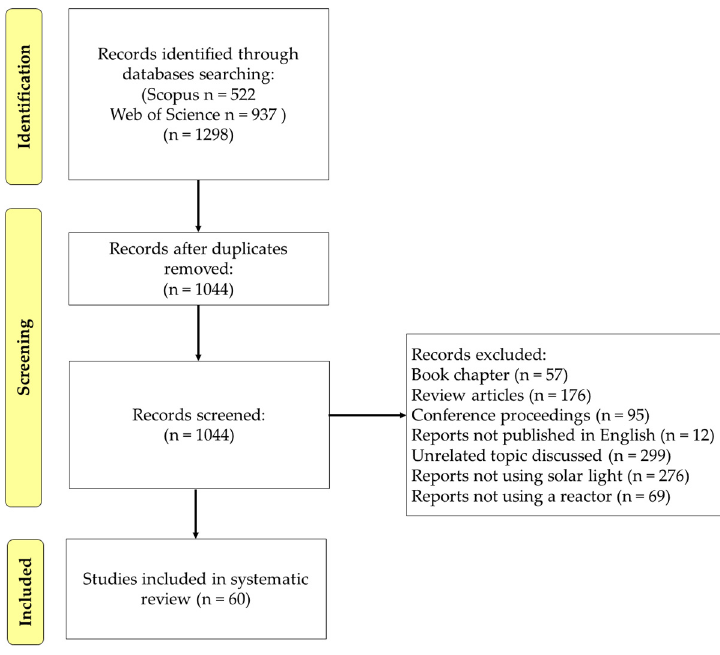
Figure 2. Flowchart for selection of literature.